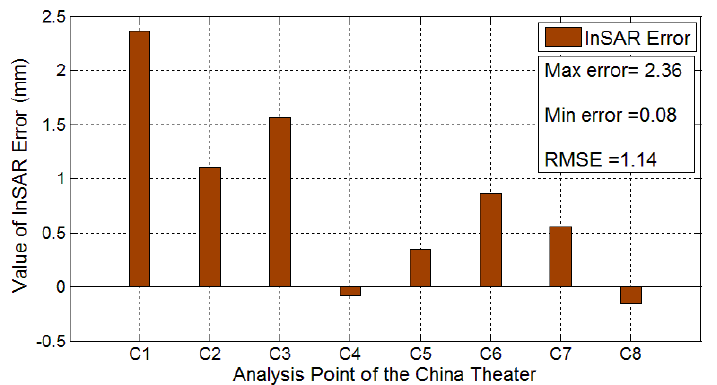
Figure 13. Measurement error between the extracted InSAR displacement and the truth leveling data in the China Theater, bigger column correspond to larger error.